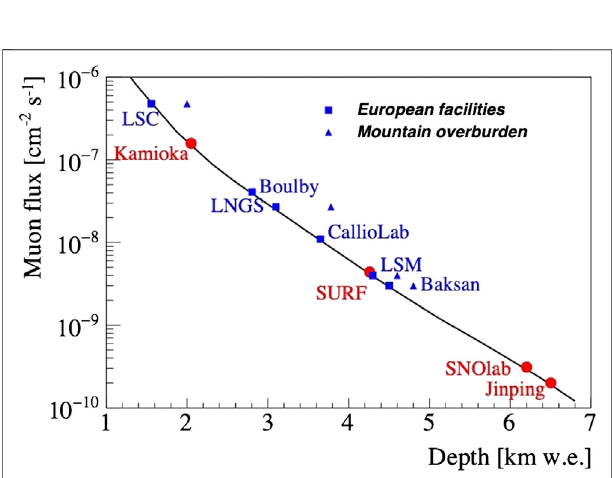
FIGURE 2 | Muon fl ux in underground laboratories. The muon fl ux in DULS is given against depth. The solid line shows the muon fl ux under a fl at surface pro fi le. Triangles show the maximum depth taking into account the real mountain pro fi le.